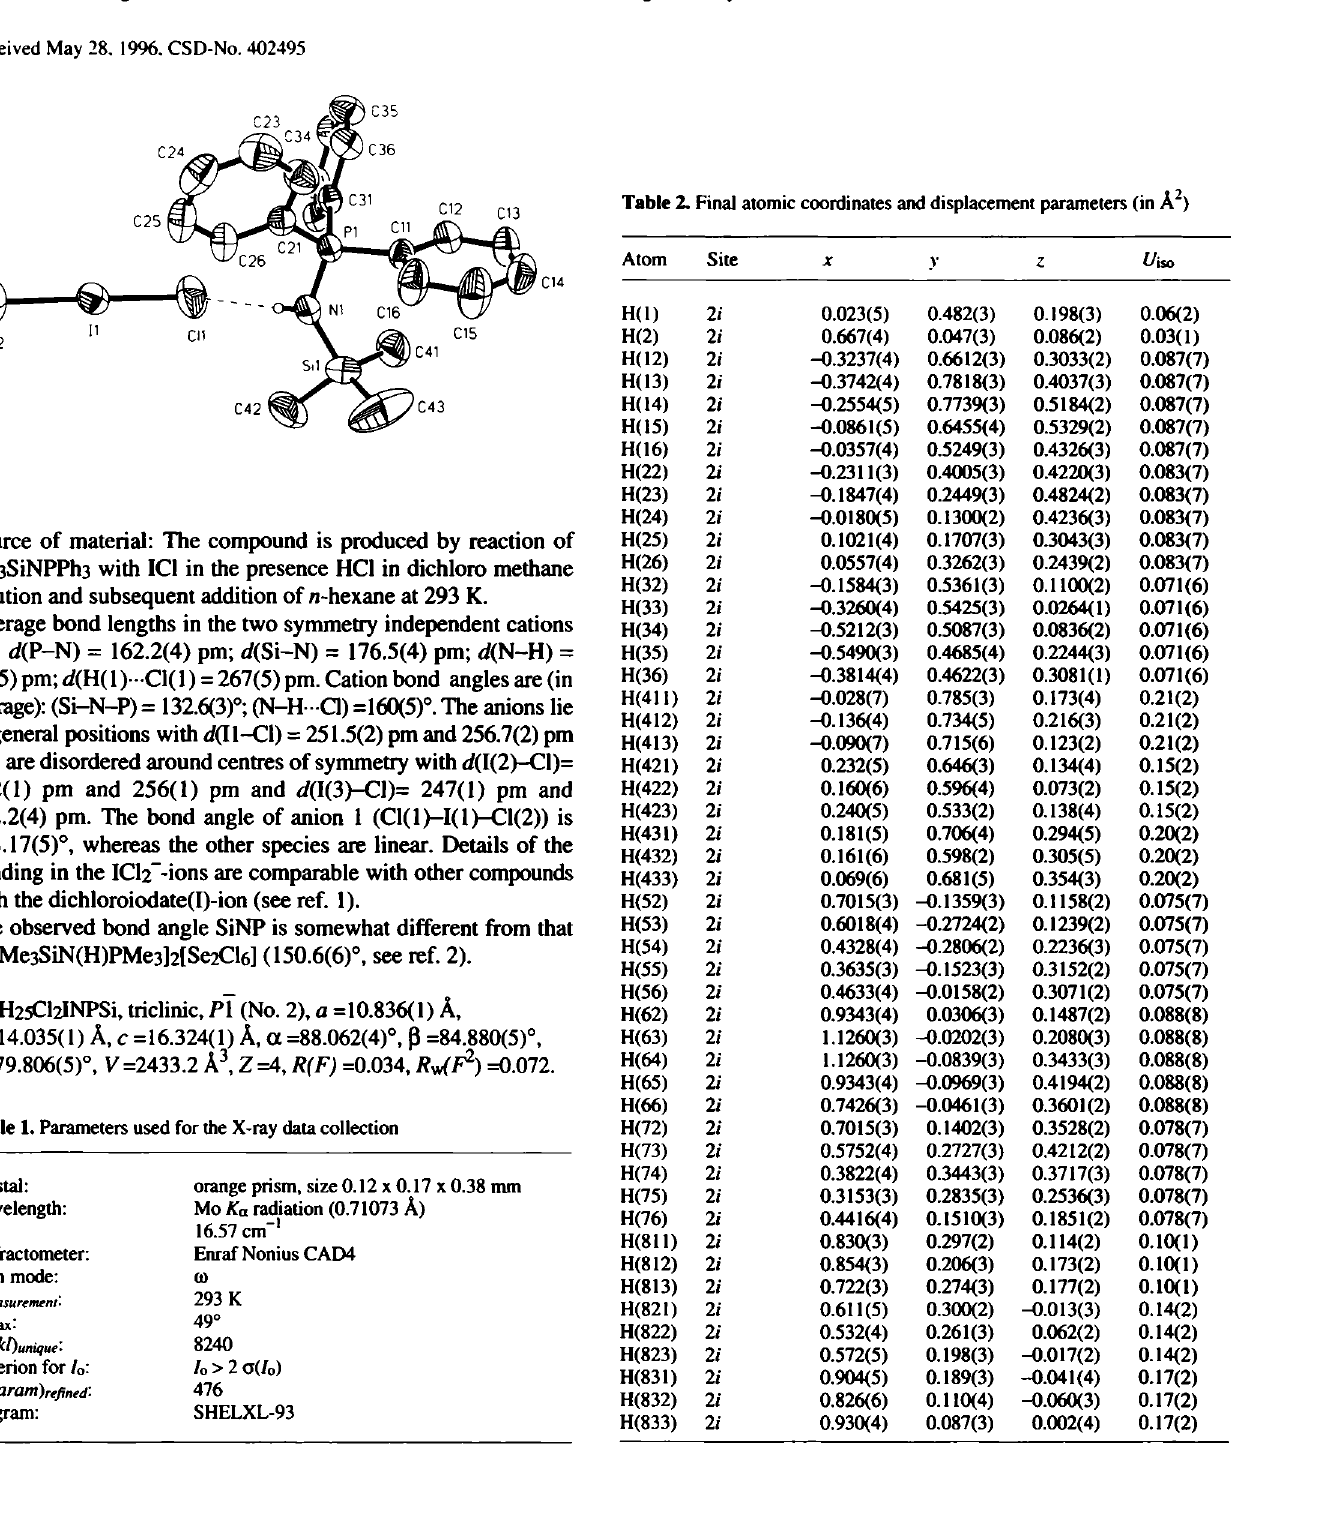
Table 2. Final atomic coordinates and displacement parameters (in Â 2